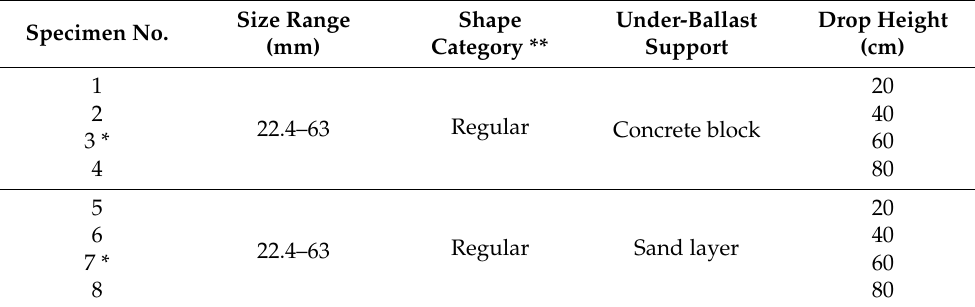
Table 2. The impact-load-test matrix for multiple-size ballasts. Specimen